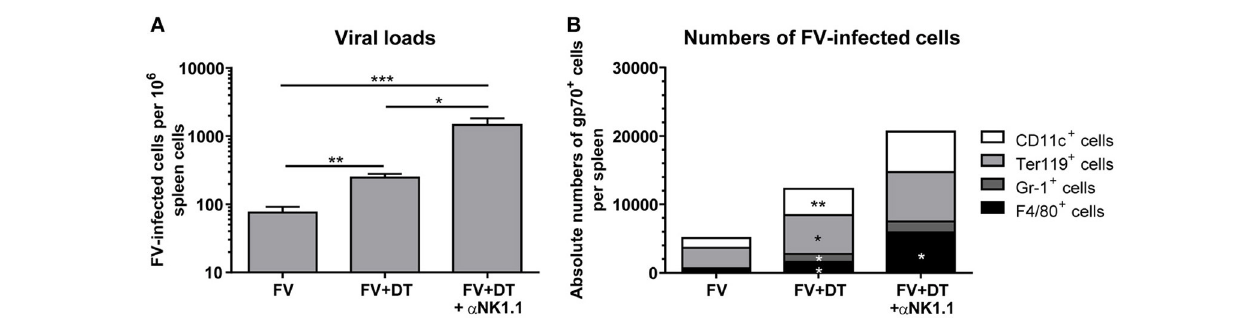
FIGURE 3 | Viral loads and numbers of FV-infected cells after Treg depletion. Mice were infected with FV and spleens were harvested at 3 dpi. In one group, Tregs were depleted by repeated injections of DT into DEREG mice (FV + DT). Additionally, one group of Treg-depleted mice were ablated for NK cell by repeated injections with the NK1.1-specific monoclonal antibody PK136 (FV + DT + α NK1.1). Viral loads were analyzed by an infectious center assay and results are shown in (A) by mean values, with SEM indicated by error bars. At least 6 animals per group from at least two independent experiments were used for the analysis (FV n = 19, FV + DT n = 20, FV + DT + α NK1.1 n = 6). Outliers were removed using the Rout method. Statistically significant differences were analyzed by the Kruskal–Wallis test. (B) Absolute numbers of FV-infected cells were analyzed by the expression of FV gp70 antigen on the cell surface of CD11c + DCs, Ter119 + erythroblasts, Gr-1 + CD11b + granulocytes, and F4/80 + CD11b + macrophages (FV n = 9, FV + DT n = 9, FV + DT + α NK1.1 n = 6). Statistically significant differences between the group of FV-infected and FV + DT group or comparison between FV + DT and FV + DT + α NK1.1 were analyzed by Mann-Whitney test and are indicated as follows: